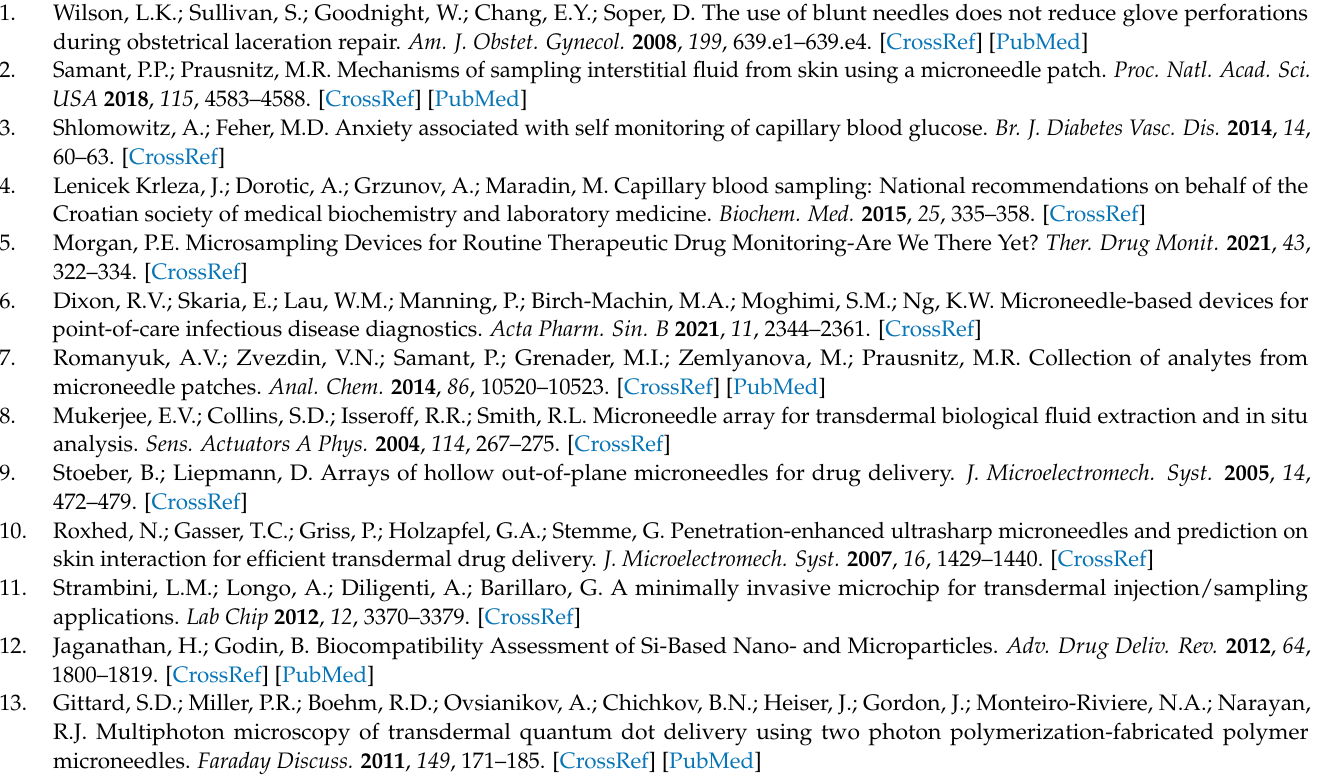
Chip design for SIMPLE pressure generation measurements, Figure S3: Measured volumes during pressure generation measurement; Section S4: Laser drilling settings characterization, Figure S4: Complete overview of the laser drilling results; Section S5: Flow characterization of the fabricated HMNAs, Figure S5: Bar charts of the pressure drops for distilled water flow through individual lumens, Tables S2 and S3: Results of the non-parametric Kruskal-Wallis test; Section S6: Machining artifacts, Figure S6: Extra images of the finished HMNAs; Section S7: Optimization of SIMPLE fabrication, Figure S7: Generated pressures by the SIMPLE; Section S8: Proof-of-concept sampling patch flow rates, Figure S8: Bar charts depicting average measured sampling flow rates, Figure S9: Volume-to-time graphs; Video S1: Self-powered patch for sampling